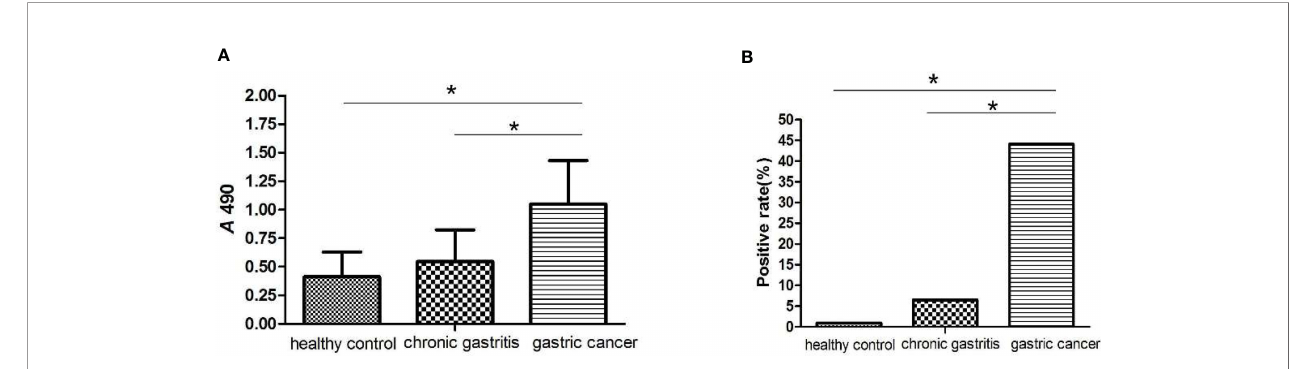
FIGURE 11 | ELISA analysis of MAGE-A3 speci fi c IgG antibodies in the serum of gastric cancer. (A) MAGE-A3 speci fi c serum IgG antibody levels in three groups of patients with healthy controls, chronic gastritis and gastric cancer. (B) The serum antibody positive detection rate of MAGE-A3 in each group. *P<0.05.